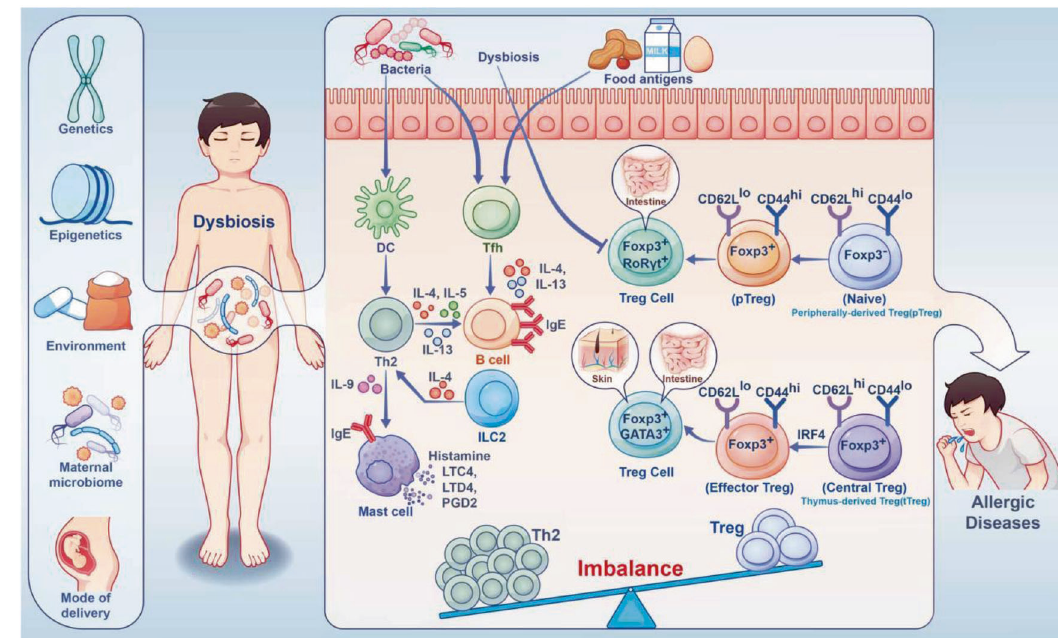
Fig. 3 Immune imbalance caused by dysbiosis under the combined effect of gene environment in IgE-related FA. During childhood, the human microbiota is in fl uenced by a combination of the maternal microbiome, mode of delivery, genetics, epigenetics, environment, etc. Dysbiosis resulting from aberrant damage to the gut microbiota early in life impairs Treg differentiation. This results in imbalance of Treg and Th2 cells. Food allergens and the microbiota promote T follicular helper (Tfh) responses to induce B cells, which produce large amounts of IgE through IL-4, IL-13 cytokines, causing allergic